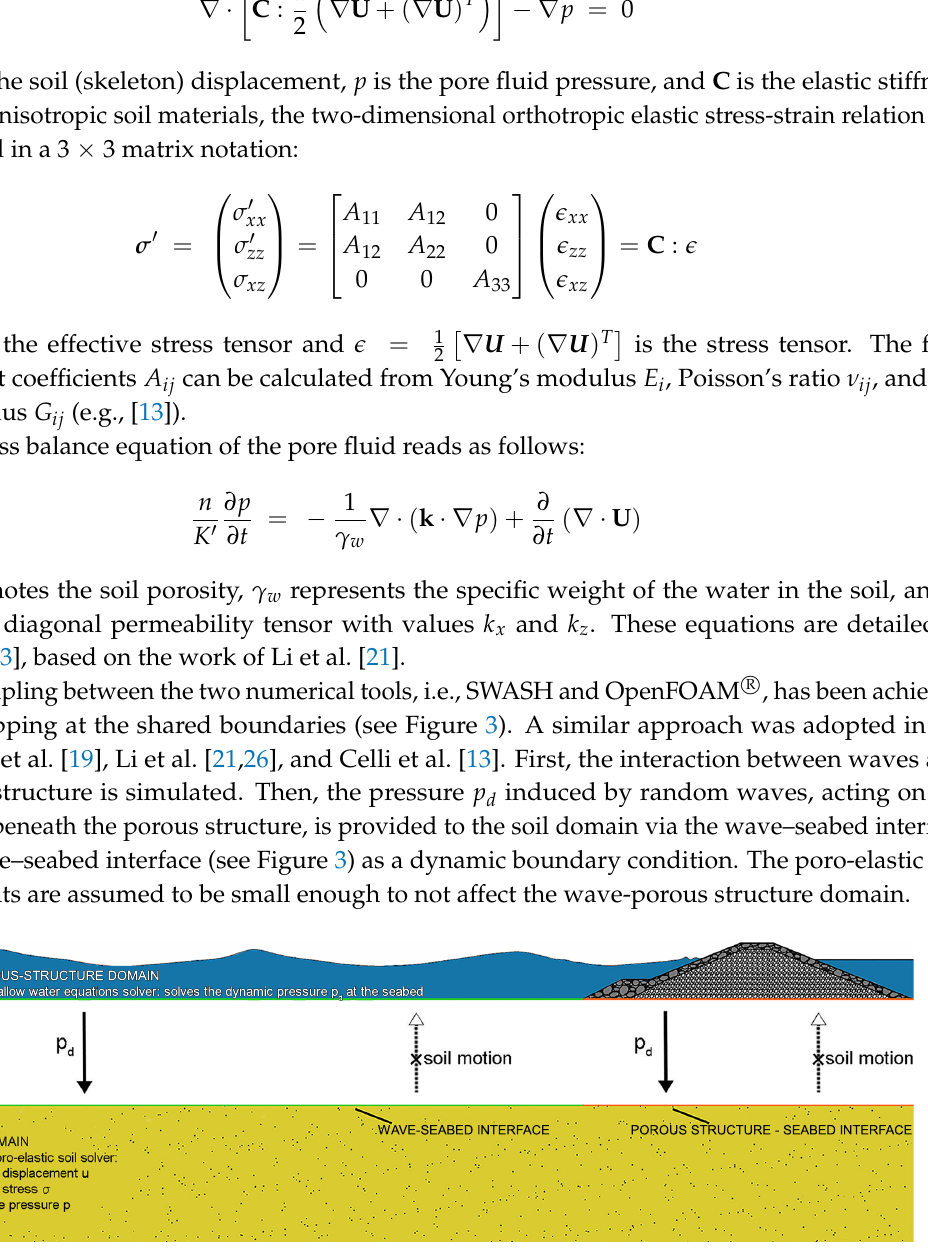
Figure 3. One-way boundary condition for wave-structure-seabed